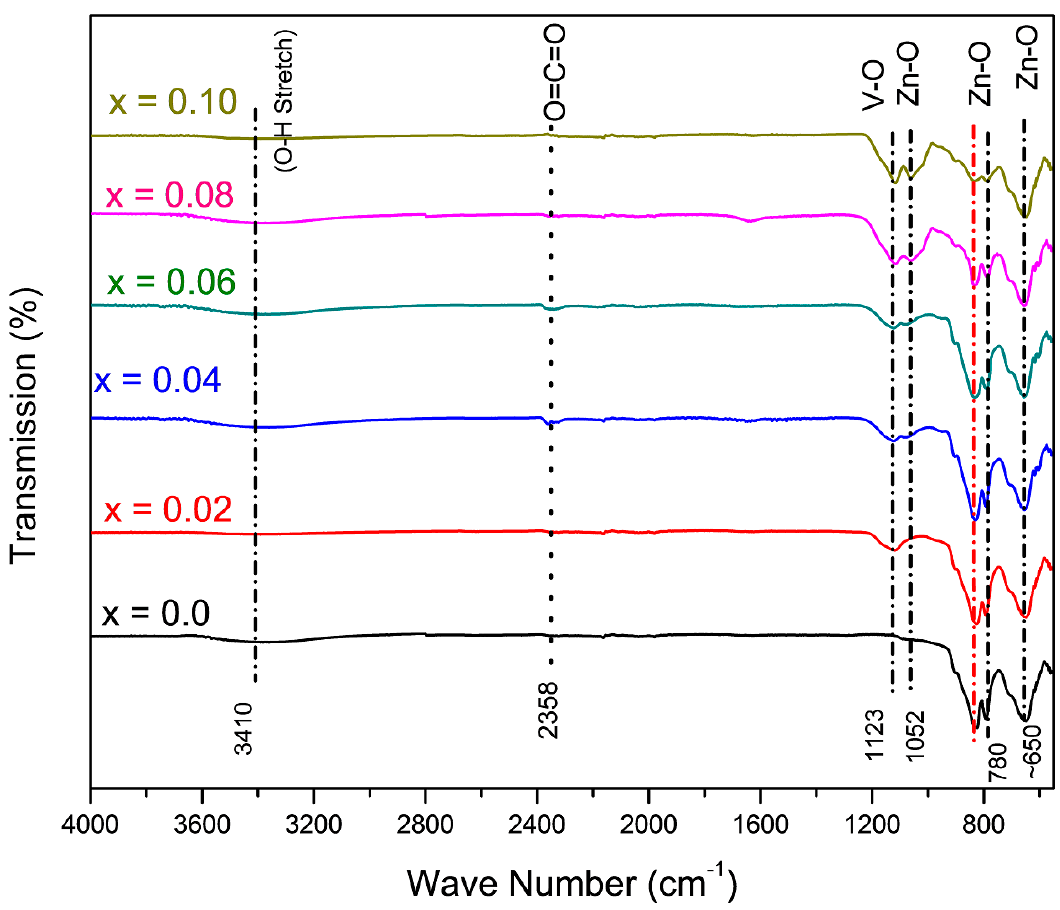
Figure 5. Attenuated total reflection-Fourier transform infrared spectroscopy (ATR-FTIR) spectra of undoped and V-doped ZnO nanoparticles for different V concentrations (i.e. 2–10% vanadium- doped).